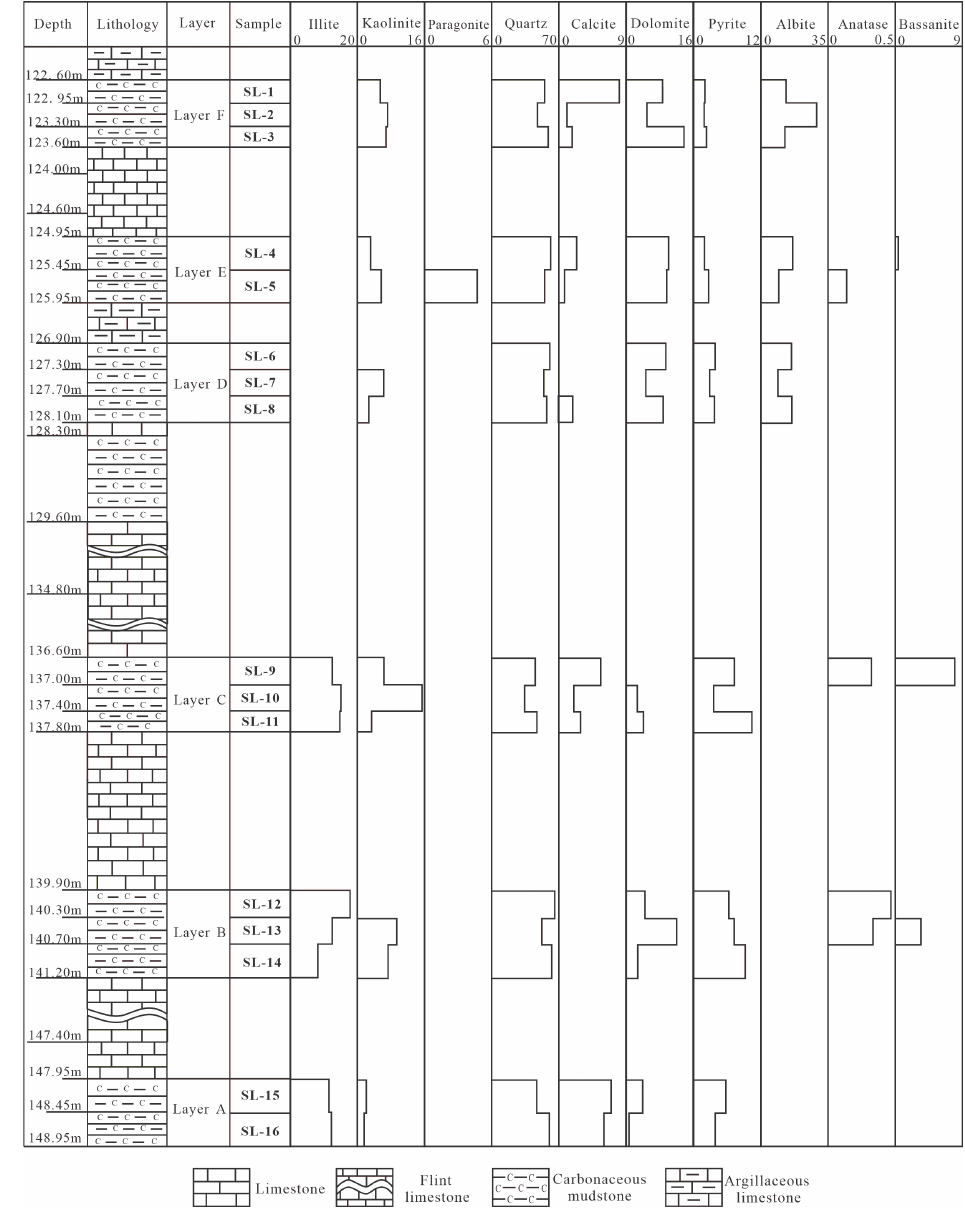
Figure 5. Vertical distribution of minerals throughout borehole SL profile